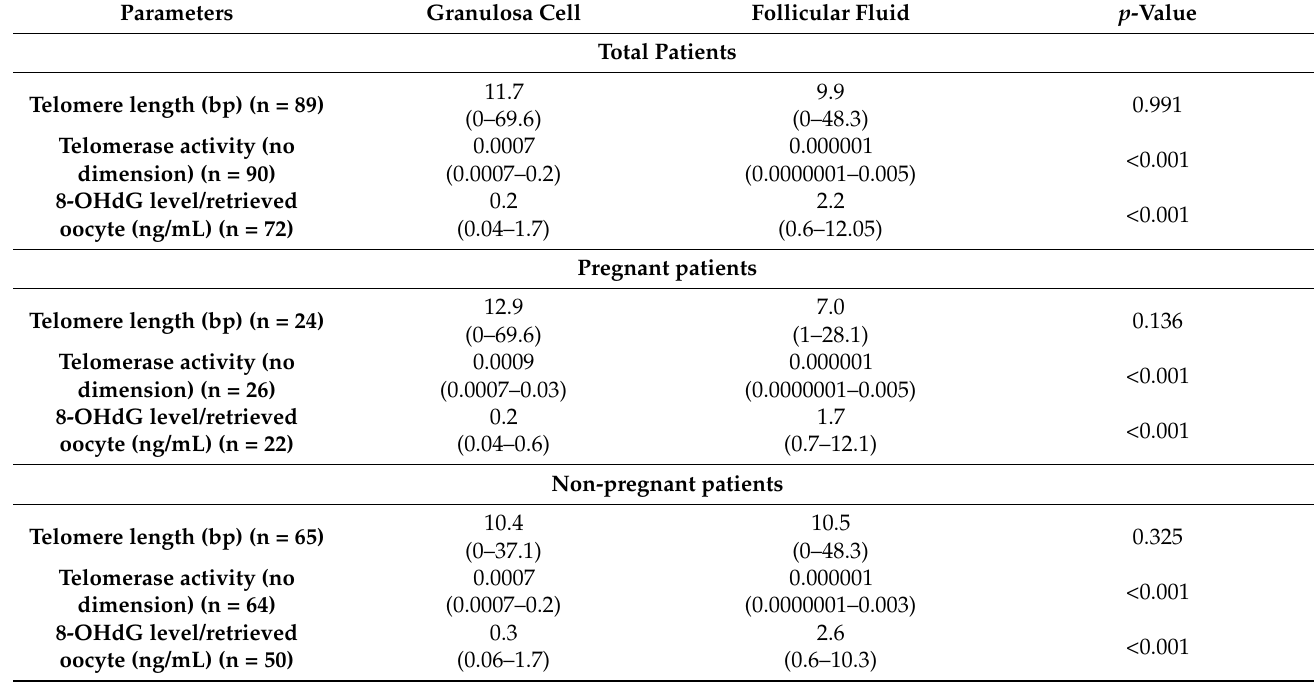
Table 8. Telomere length, telomerase activity and 8-OHdG levels in granulosa cells and follicular fluid in the total, pregnant and non-pregnant